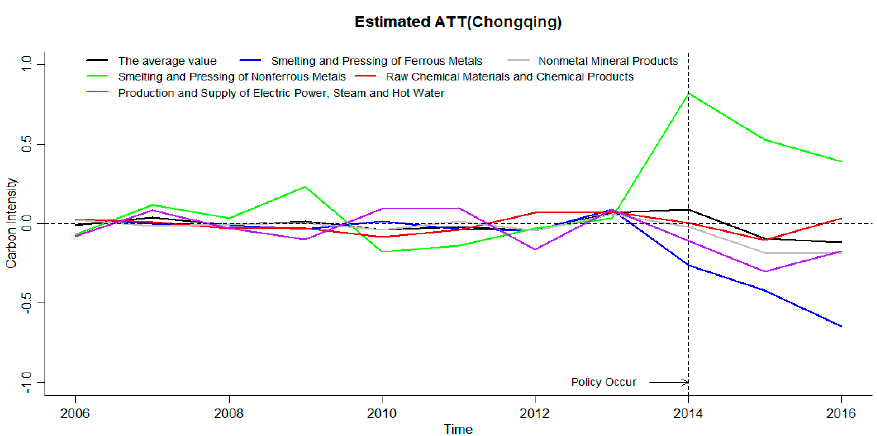
Figure 5. The impact of an ETS on industry carbon emission reduction rates in Chongqing.